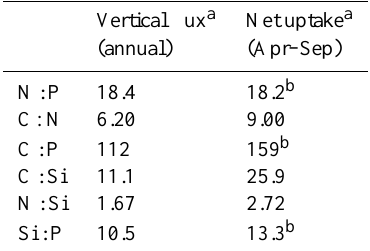
Table 3. Stoichiometric (median) ratios of computed monthly verti- cal fluxes and of biological production during the period of seasonal drawdown (net community uptake).